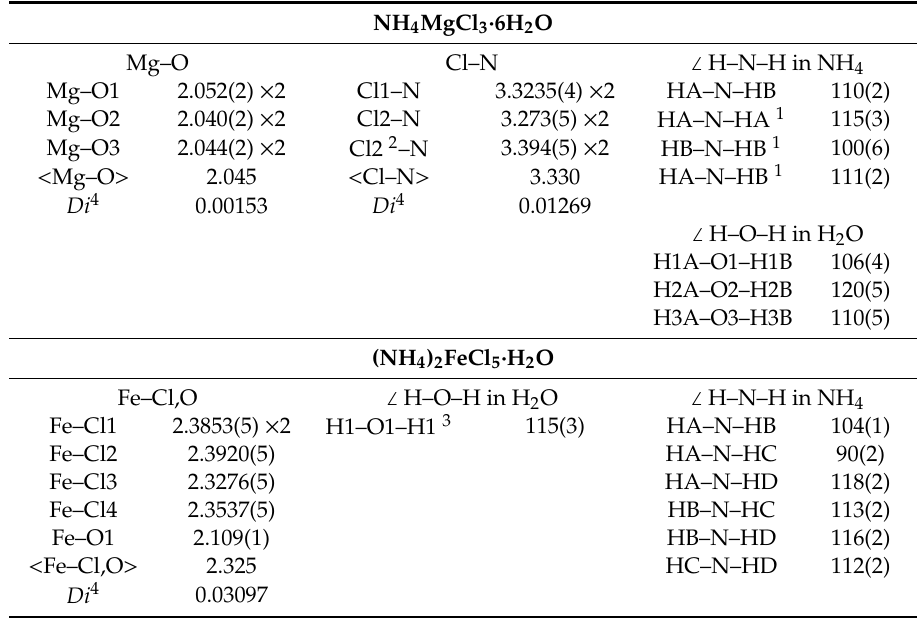
Table 7. Selected bond lengths (Å) and angles ( ◦ ) in the crystal structure of NH 4 MgCl 3 · 6H 2 O and (NH 4 ) 2 Fe 3 + Cl 5 · H 2